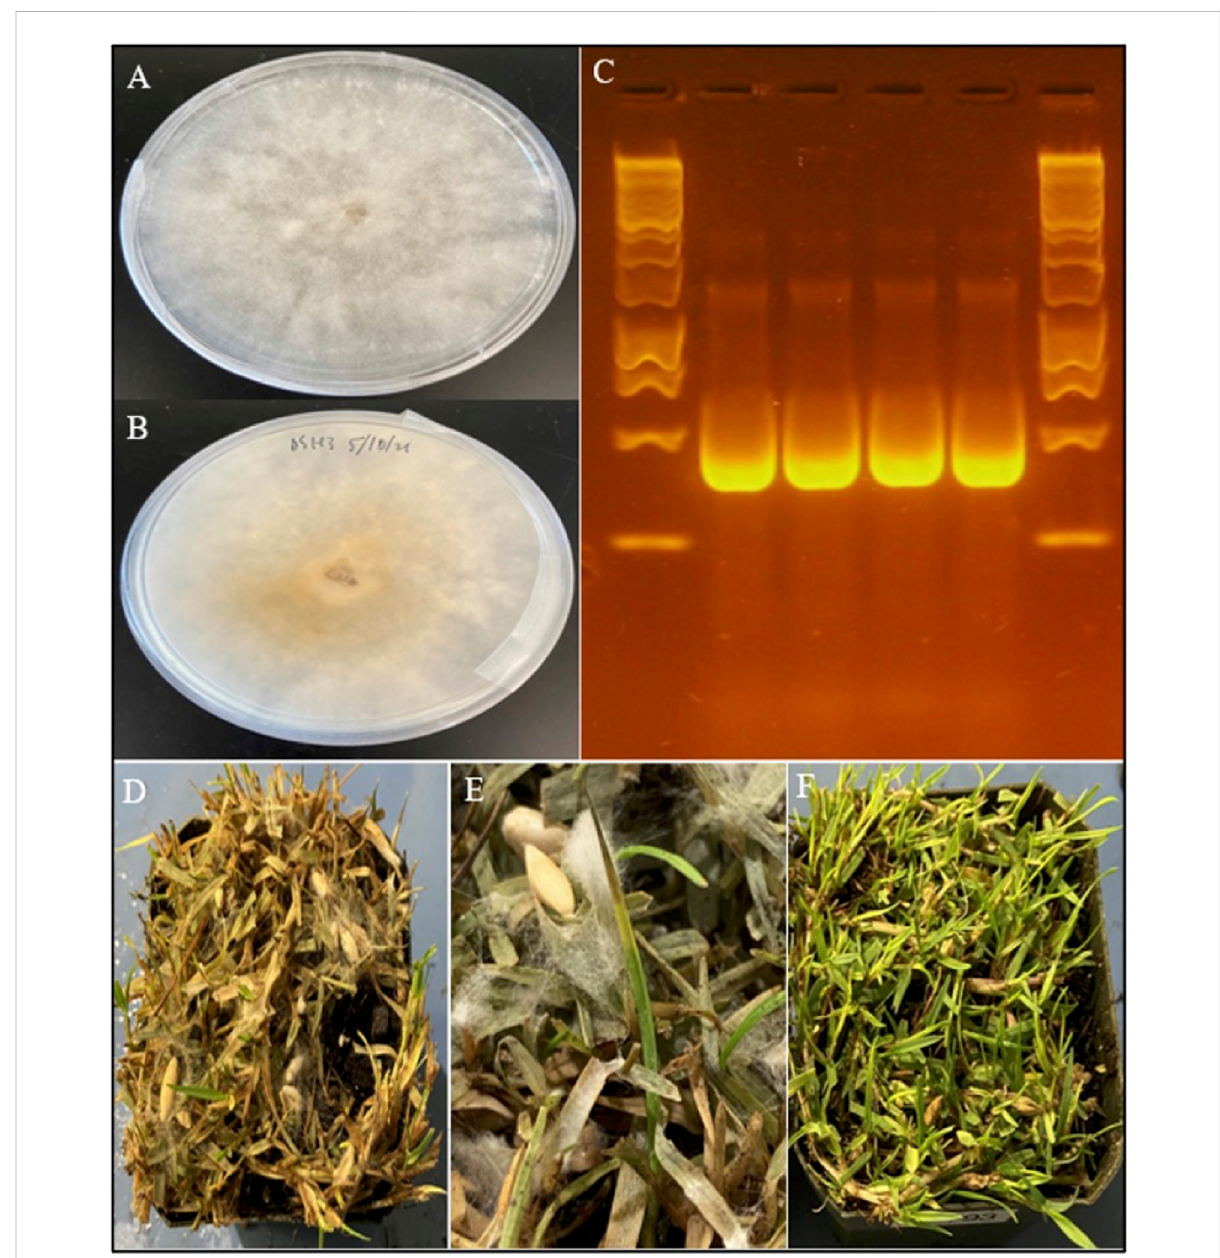
FIGURE 1 Morphology,molecularidenti fi cation,and symptoms of C. aff. paspali . (A) Frontand (B) back ofa5-dayold C . aff. paspali culture (H3isolate)on PDA media. (C) Molecular characterization of H2 (no. 1) and H3 isolates (no. 2) of C . aff. paspali along with two reference isolates DS-SP of C. monteithiana (no. 3) and DS-CB of C. jacksonii (no. 4) on the ITS region (from left to right) showing no differences in band sizes between Clarireedia species. A Thermo Scienti fi c GeneRuler 1 kb DNA Ladder was used. (D) Pathogenicity tests showing signs and symptoms of C. aff. paspali infection and (E) foliar tip dieback and aerial mycelia growth. (F) Non-inoculated